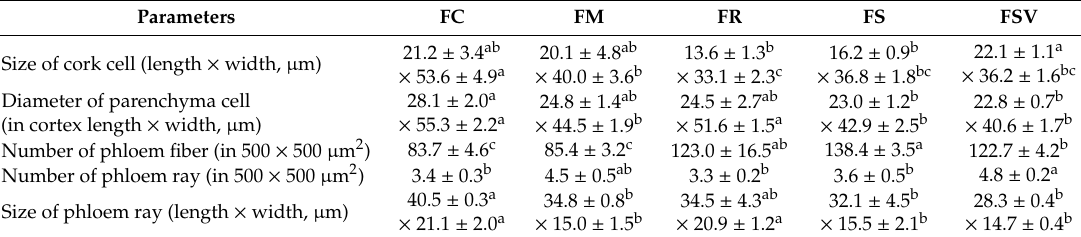
Table 4. Anatomical characteristics of the stem bark of Fraxinus plants.